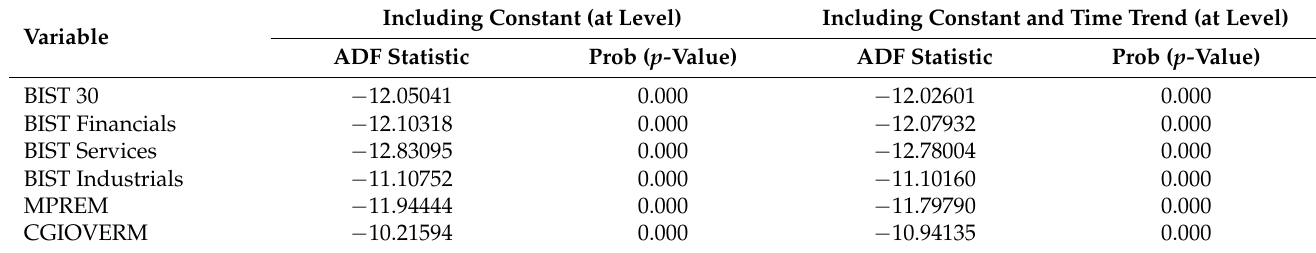
Table 2. Augmented Dickey-Fuller unit root test statistics.